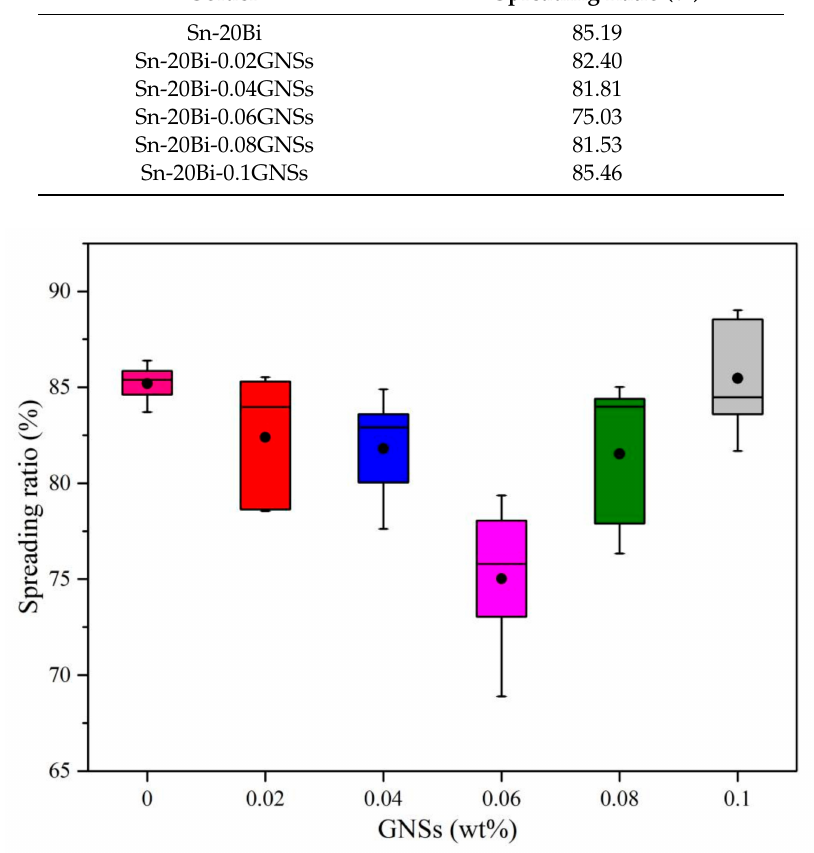
Figure 2. Spreading ratio of Sn-20Bi-xGNS solder on Cu